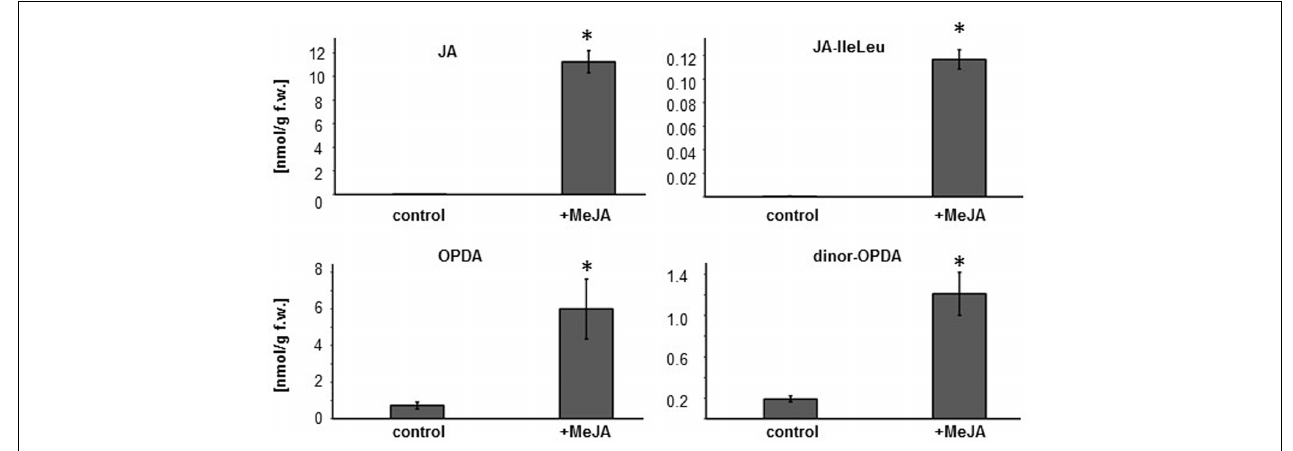
FIGURE 5 | MeJA treatment increases OPDA, dinor-OPDA, JA and JA-IleLeu concentrations in Col-0 roots. Eight day old Col-0 seedlings were transferred onto MS media with or without 50 µ M MeJA. After 48 h of treatment, approximately 100 mg of root was used for hormone measurements. Bars represent average